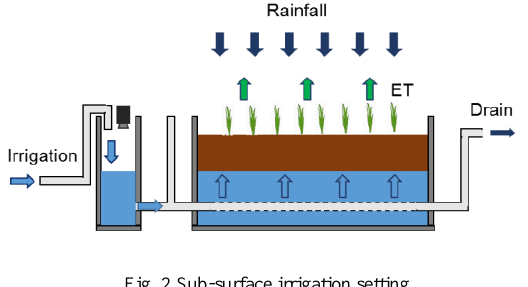
Fig. 2 Sub-surface irrigation setting